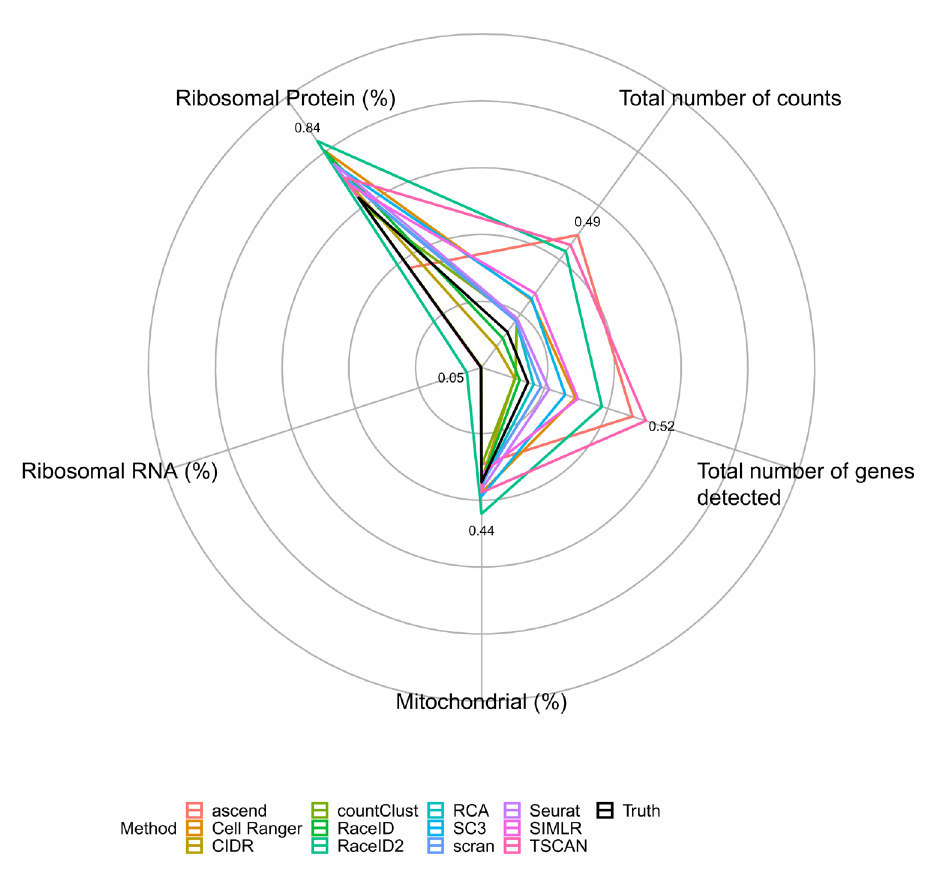
Figure 8. Radial plots describing the average effect of 5 cell features on the clustering solutions of different methods across the three silver standard datasets in evaluation 1 (R version 3.4.3). For every method and every feature the adjusted R 2 of the linear model fitting the feature by the clustering solution is